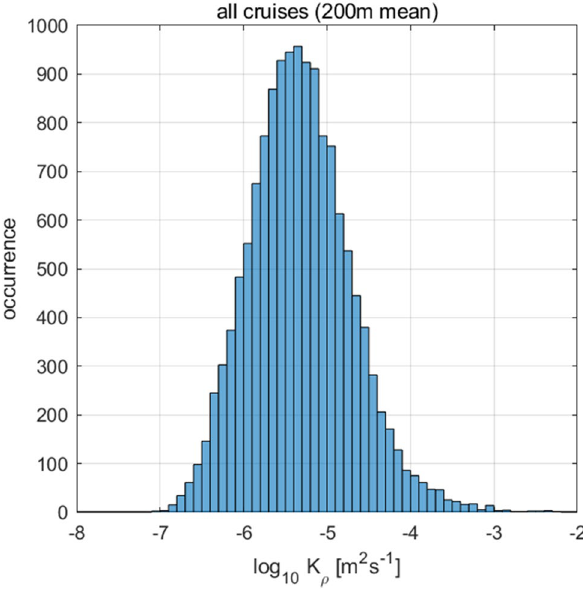
Figure 6. Occurrence of diapycnal diffusivity K ρ (= 0.2 ε / N 2 ). The vertical axis denotes the data quantity. Data averaged at 200 m after data screening are